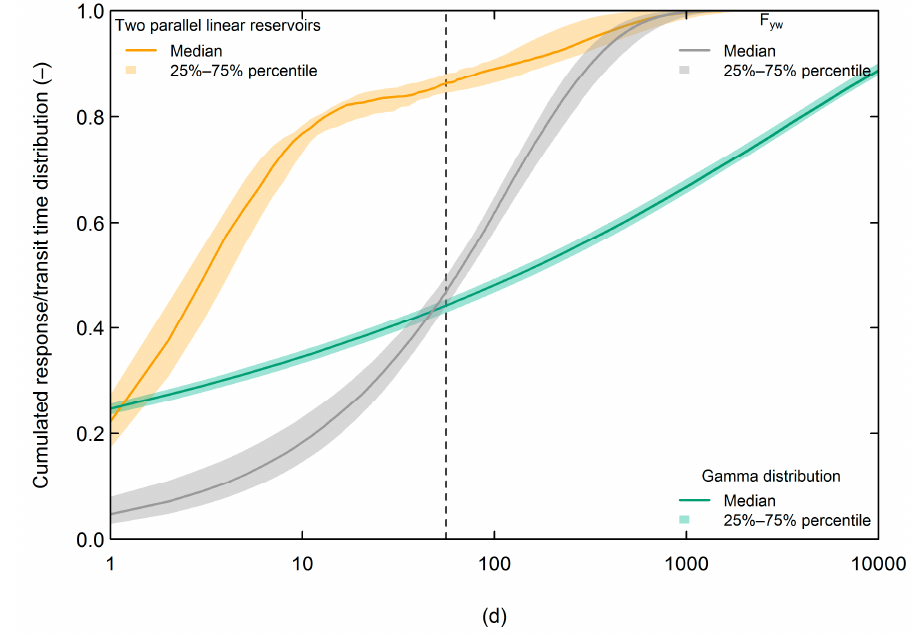
Figure 5. Cumulated response time distribution (RTD; yellow) and transit time distribution (TTD; green) estimated with TRANSEP, as well as delayed daily F yw estimated with the sine wave approach (grey). The bands indicate the interquartile range of the best 100 runs for the RTD and the TTD, and the interquartile range of the 10,000 F yw calculations. The dashed line marks the threshold age τ yw of 56